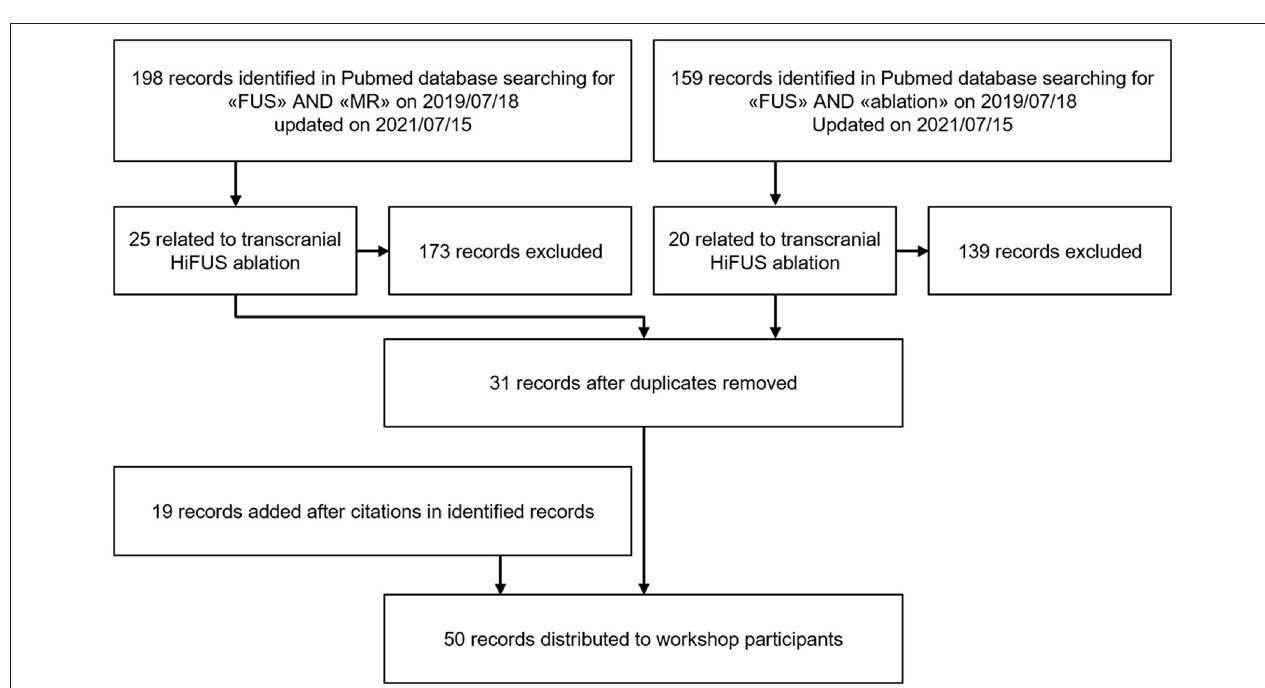
FIGURE 2 | Process of literature research and dissemination to workshop